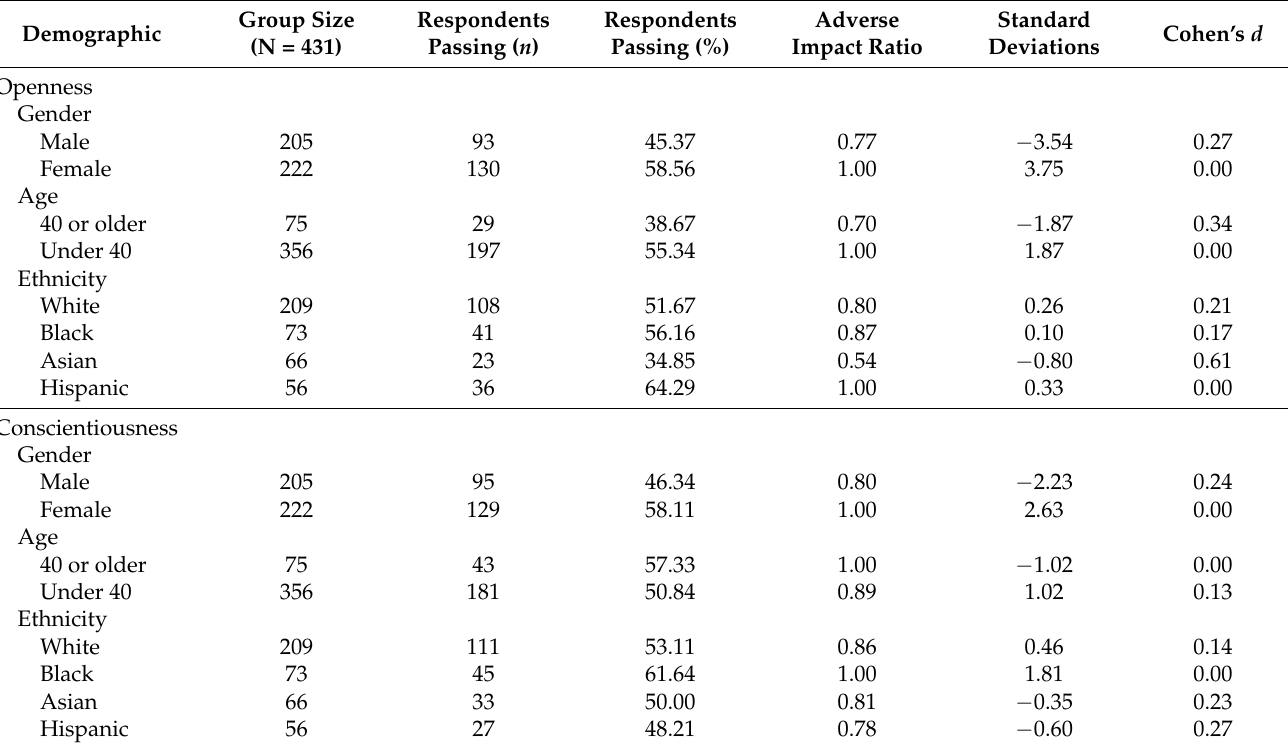
Table 6. The adverse impact analysis for the questionnaire-based assessment based on the four-fifths rule, two standard deviations rule, and Cohen’s d